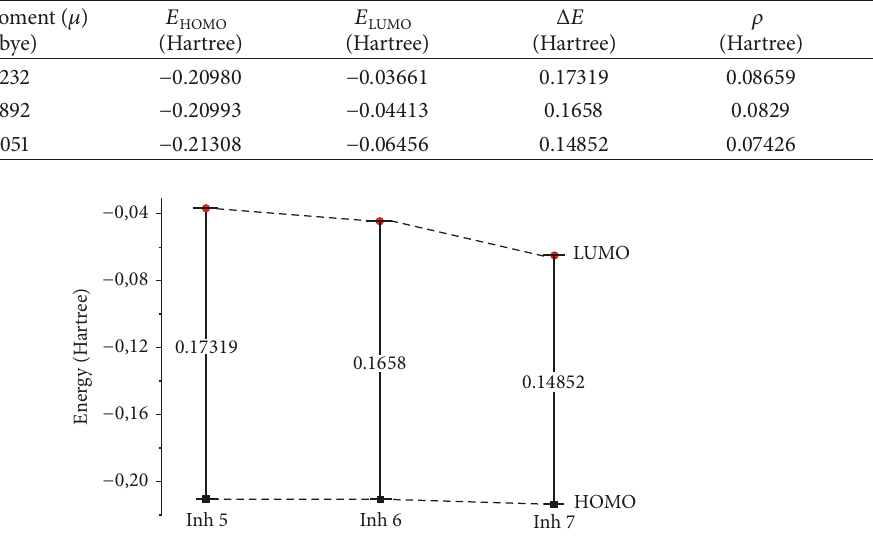
Figure 11: Correlation diagram of frontier molecular orbitals for the investigated inhibitors and their calculated Δ𝐸